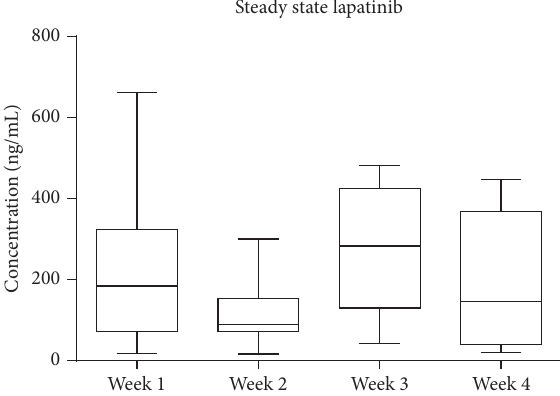
Figure 1: Circulating lapatinib measured weekly. Data shown is median with range, 𝑛 = 12 . Steady state lapatinib levels were determined by LC/MS/MS and remained similar across the four weeks of treatment ( 𝑃 > 0.05 , one-way